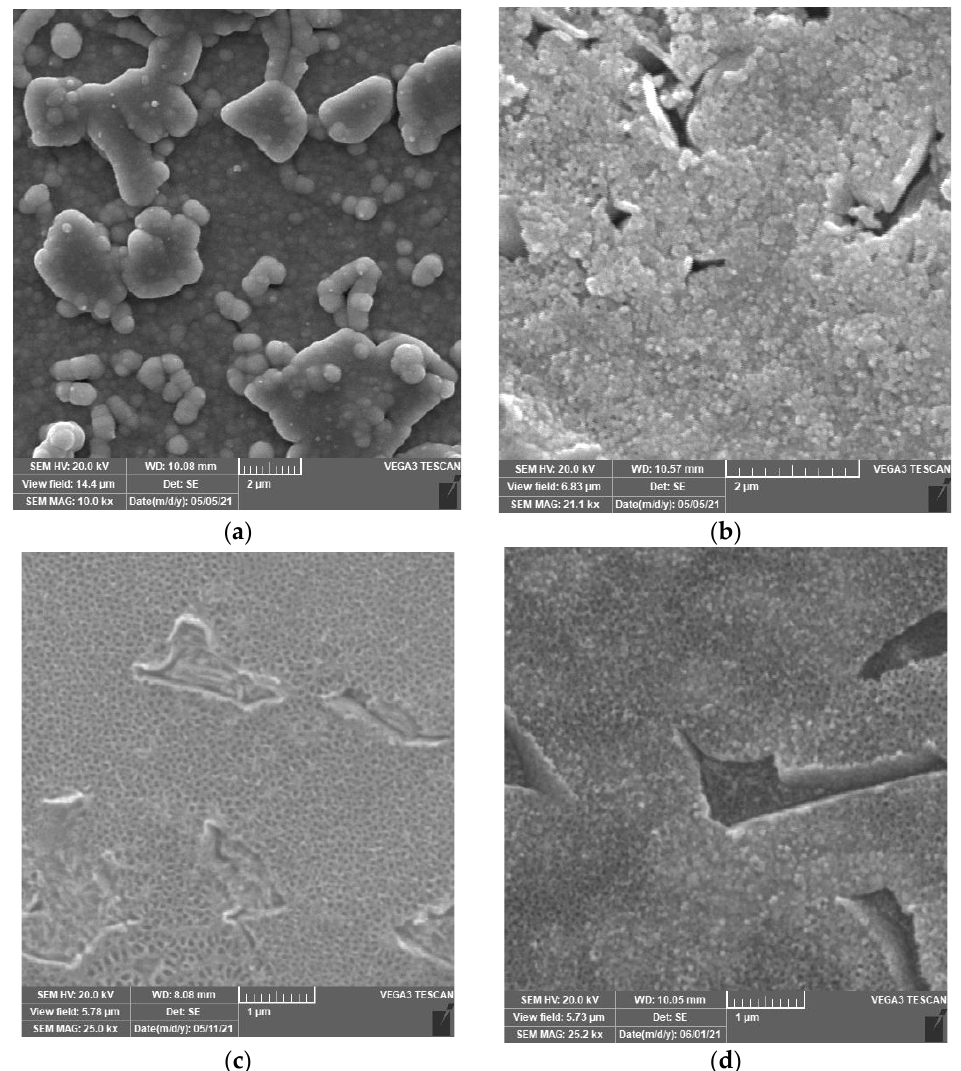
Figure 2. TiO 2 nanotubes with deposited particles of Ru by different methods: ( a ) galvanostatic mode; ( b ) cyclic polarization; ( c ) potentiostatic mode (t = 600 s); ( d ) potentiostatic mode (t = 1200 s).